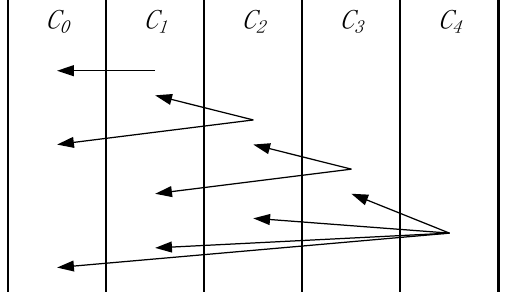
Figure 3. Sensor networks with non-uniform maximum transmission